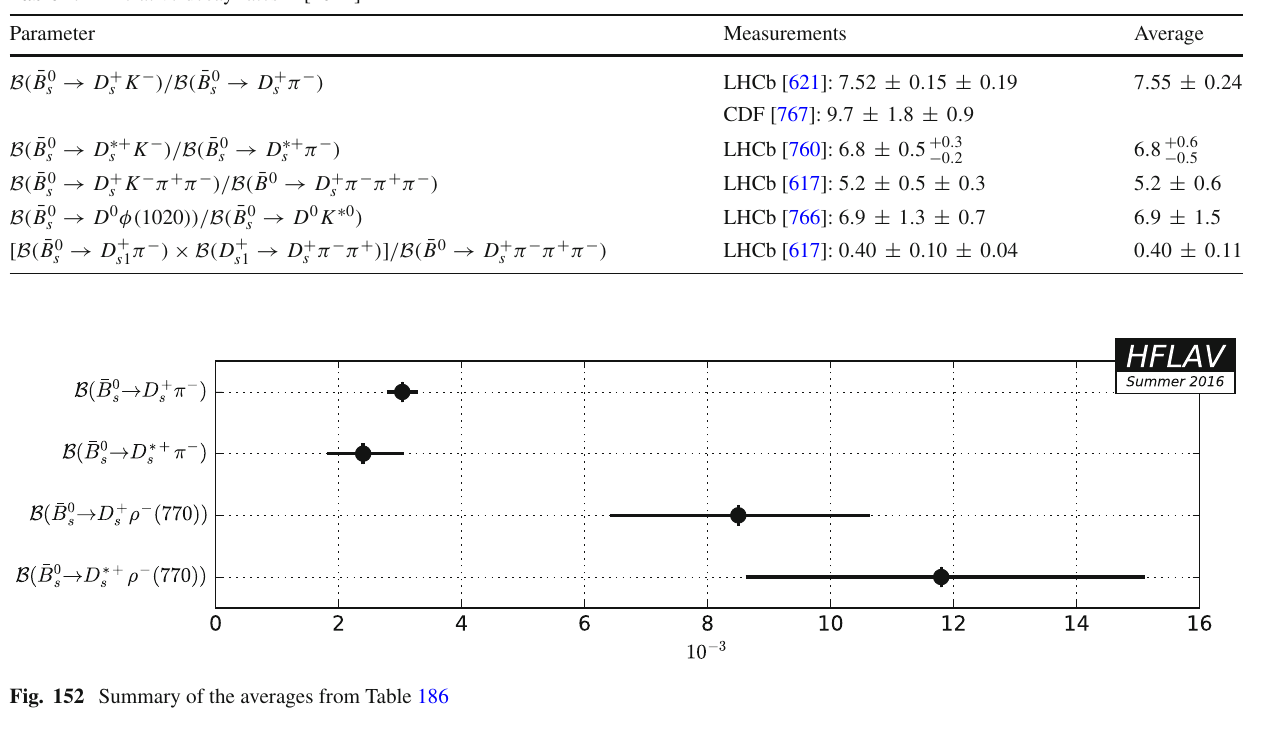
Table 191 Relative decay rates II [ 10 − 2 ]